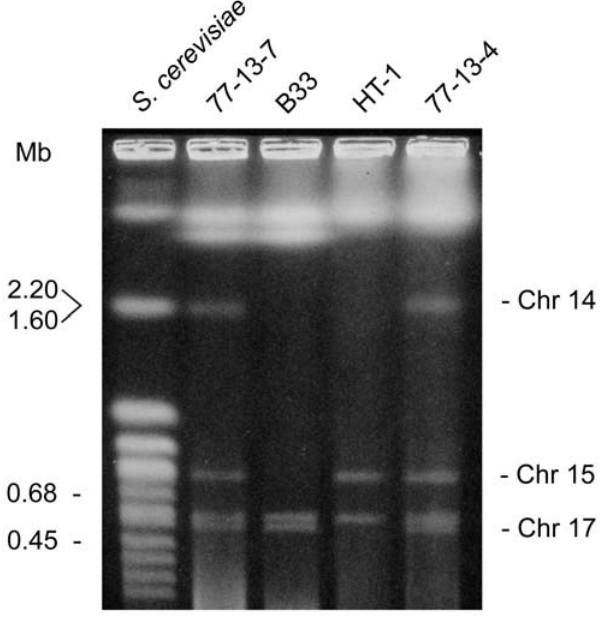
Figure 6. Partial electrophoretic karyotypes of 77-13-7, 77-13- 4, and two isolates, B33 and HT-1, derived from 77-13-7 and 77-13-4, respectively. Pulsed-Field Gel Electrophoresis conditions that allowed the resolution of the smaller chromosomes were used. Figure 7. Detection of chromosome-specific sequences found on the ends of chromosomes 14, 15, and 17 in isolates 77-13-7, 77-13-4, and two isolates, B33 and HT-1, derived from 77-13-7 and 77-13-4, respectively. Primers from the scaffolds at the ends of the chromosomes were used to produce PCR products from the end of chromosome 14 (A), chromosome 15 (B), and chromosome 17